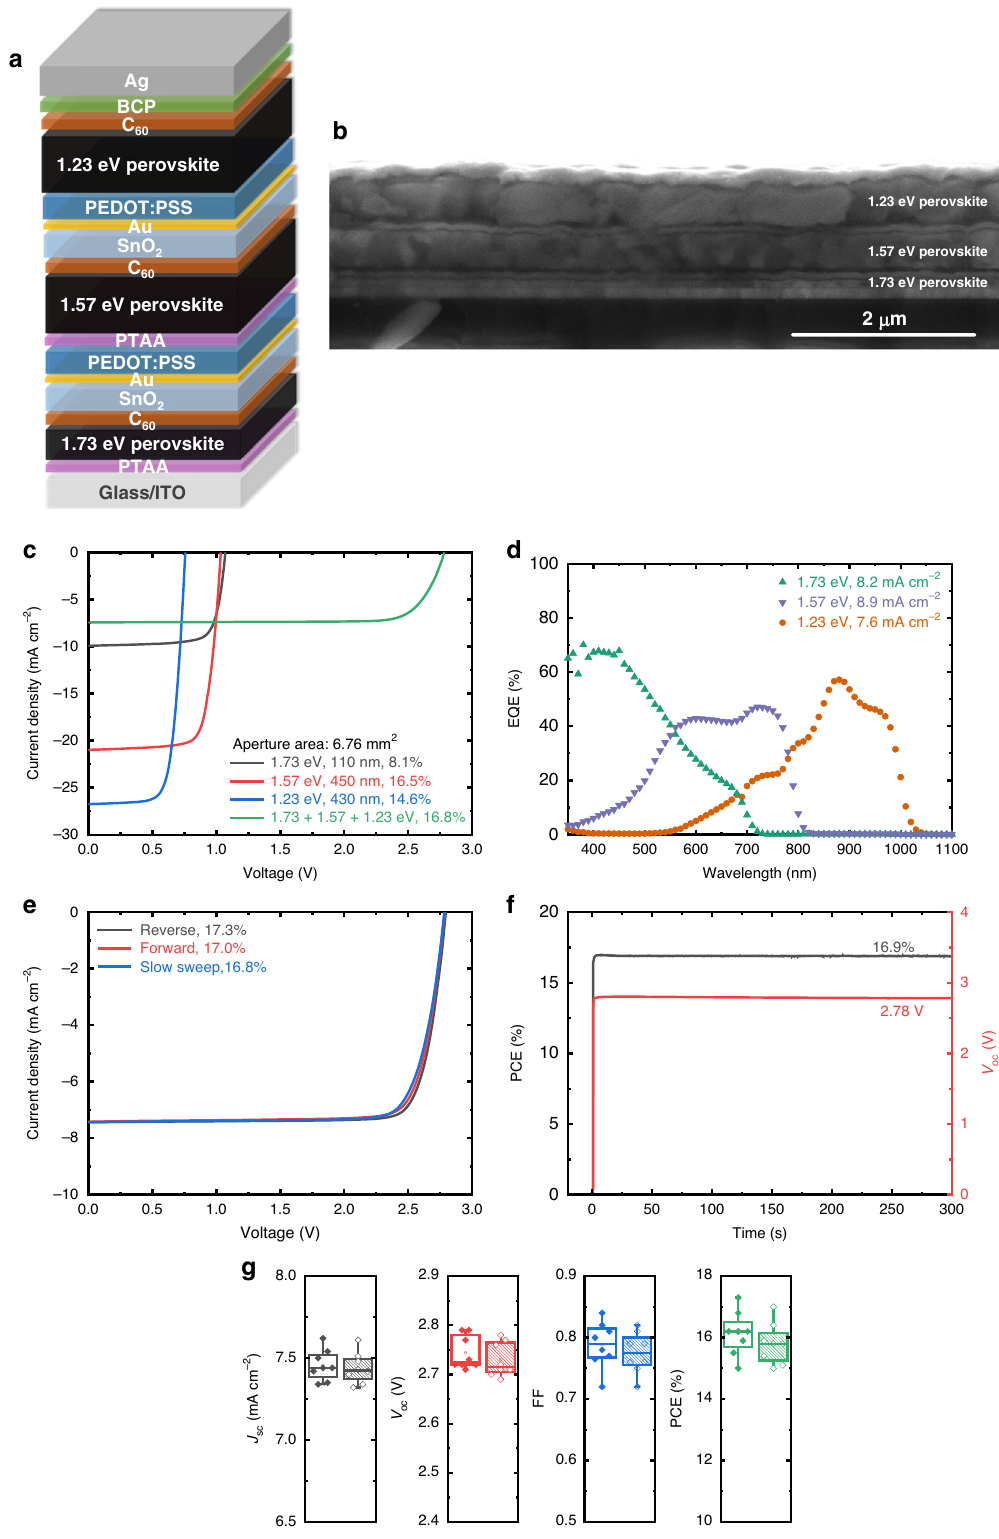
Fig. 4 Device structure and PV performance of the optimized monolithic triple-junction solar cell. Device con fi guration ( a ) and the corresponding cross- sectional SEM image ( b ) of the triple cell. Scale bar is 2 μ m. c Stabilized J – V curves of the best-performing triple device and the corresponding 1.73eV, 1.57eV, and 1.23eV single-junction PSCs prepared in the same batch (6.76mm 2 aperture area). d EQE spectra of 1.73eV, 1.57eV, and 1.23eV sub-cells in a triple- junction device with C 60 /SALD-SnO 2 /Au/PEDOT:PSS ICLs, the J sc was obtained by integrating with the AM 1.5G spectrum. Reverse, forward, and stabilized J – V scans ( e ) and PCE and V oc tracking ( e ) of the best-performing triple device. g Statistical distributions of PV parameters of J sc , V oc , FF, and PCE of triple-junction solar cells, measured under fast J – V sweep in reverse (left) and forward (right) directions. In the boxplots the mean (open circle), median (center line), 25th and 75th percentiles (box limits), and 5th and 95th percentiles (whiskers) are shown. Source data are provided as a Source Data fi